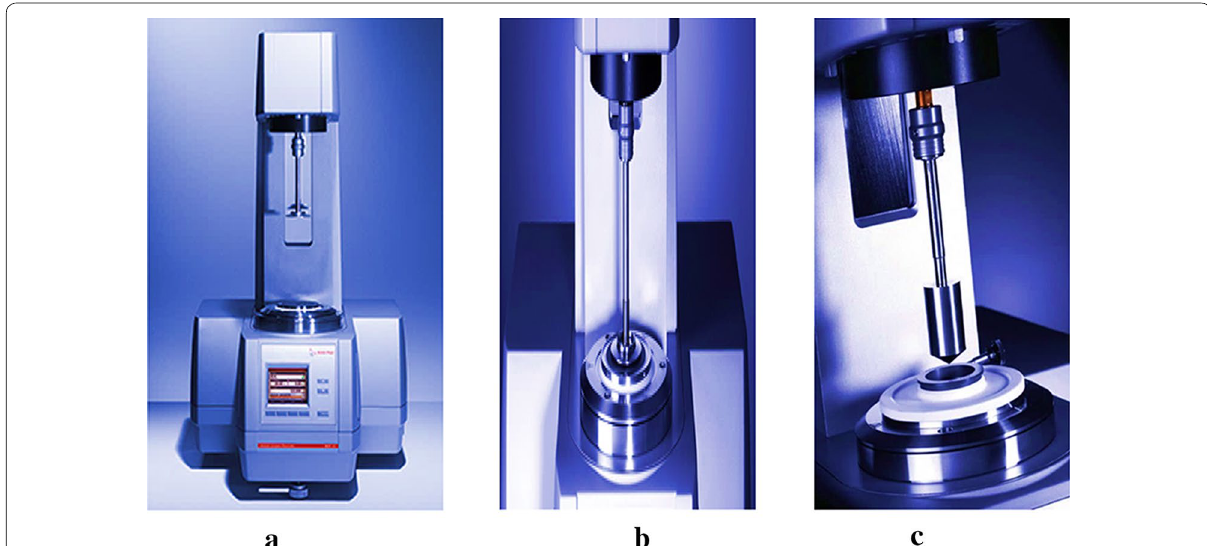
Fig. 2 Experimental setup for rheological measurements. a Rheometer MCR302 Anton-Paar. b Parallel plate setting, c Concentric cylinder